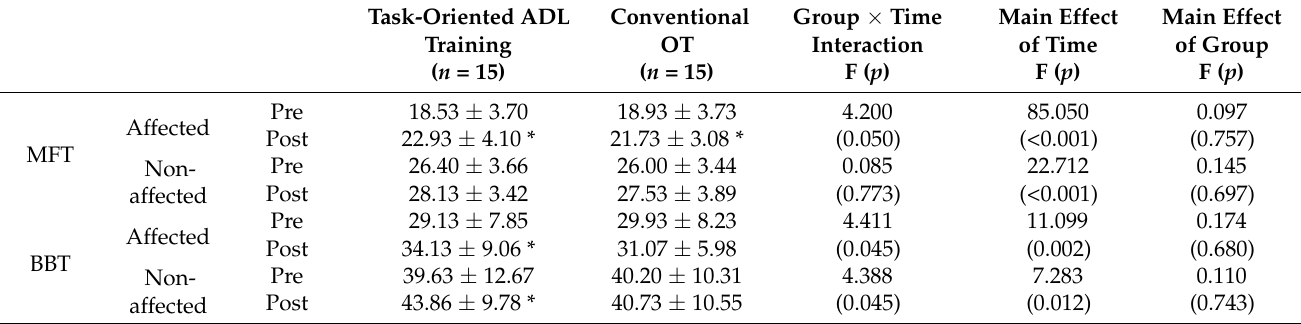
Table 3. Primary outcome variables before and after the interventions between the groups ( n = 30).